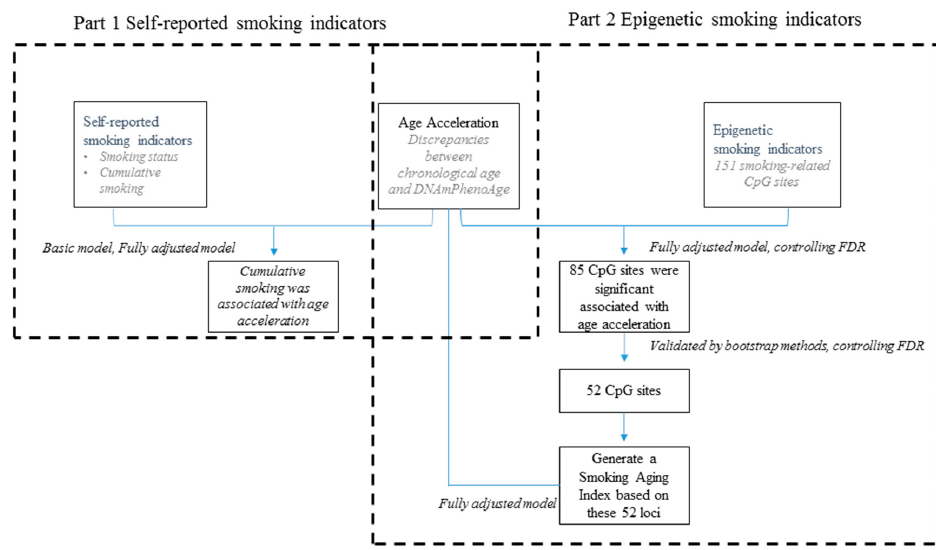
Figure 1. Flow chart of the generalized linear mixed model used to assess the relationship between smoking indicators and DNA methylation phenotypic age (DNAmPhenoAge) acceleration